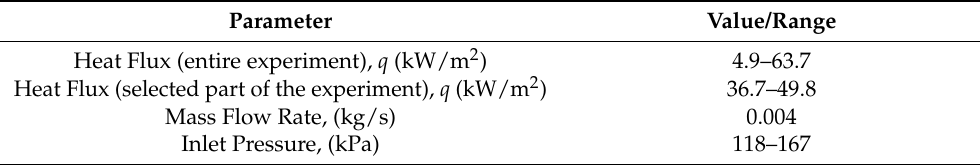
Table 1. The main experimental parameters for the heat transfer